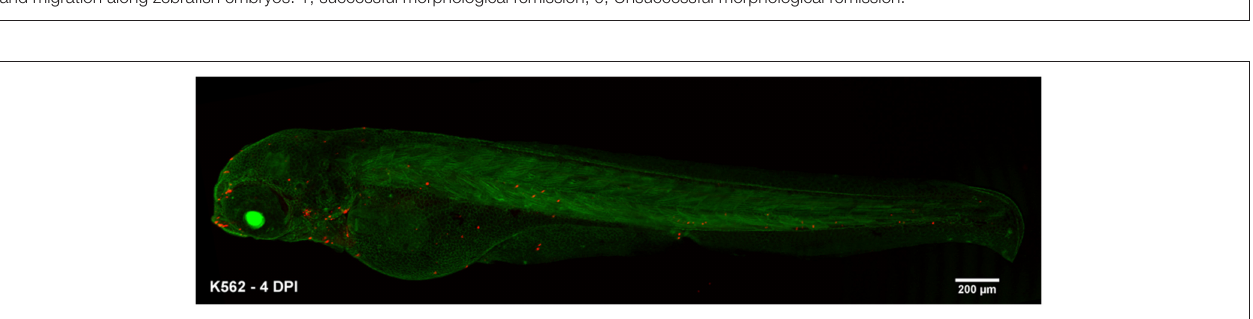
FIGURE 8 | Alternative xenograft assay for long-term analysis. Transgenic β -actin zebrafish embryos were injected with k562 cells stained with C-DiL at 48 hpf. The visualization of the cells was performed at 4 dpi. At this time the cells were easily detected and maintained their tropism toward the hematopoietic tissue of the fish. K562 xenografted cells at 4